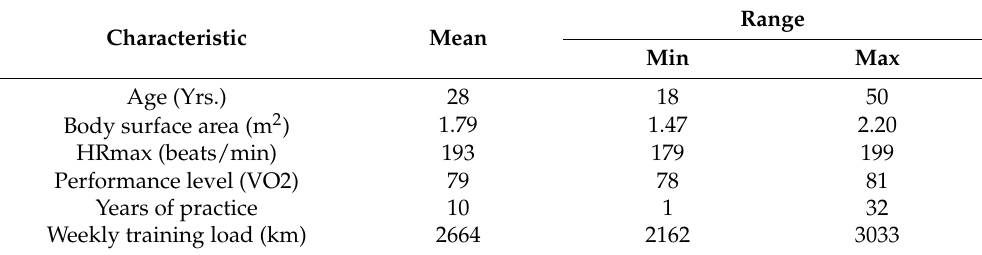
Table 1. Summary of cyclists’ characteristics ( n = 406).